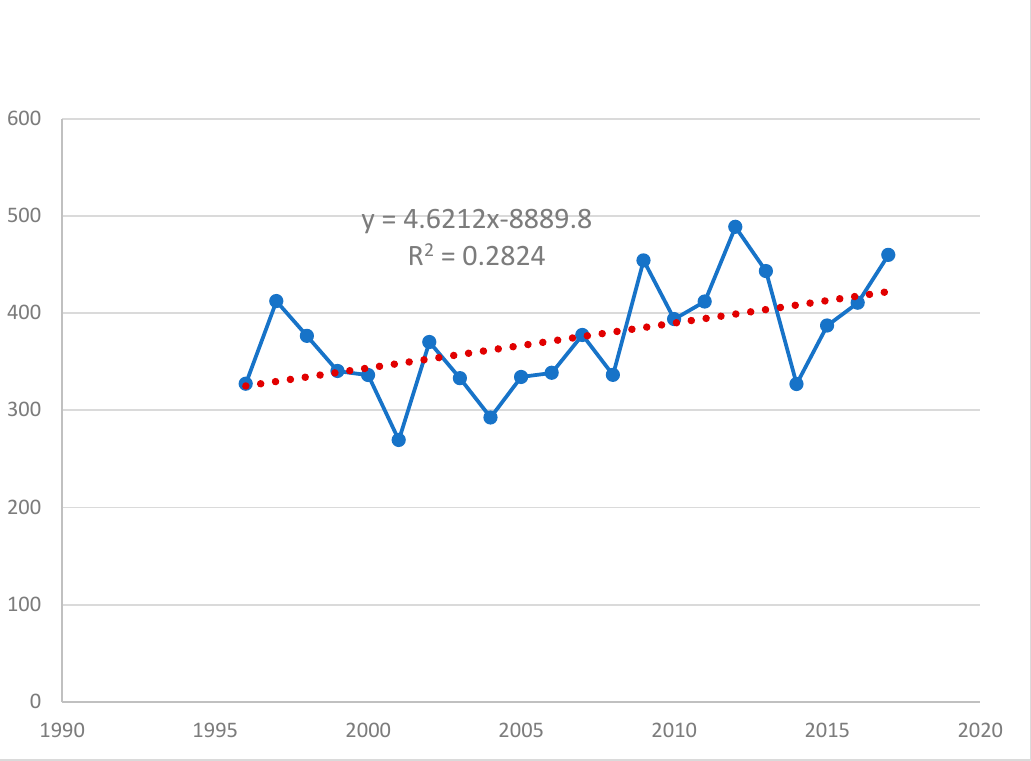
Figure 3. Trend analysis plot for annual rainfall (MM) in Cross River State. Source: Author’s computation from data obtained from CBN.